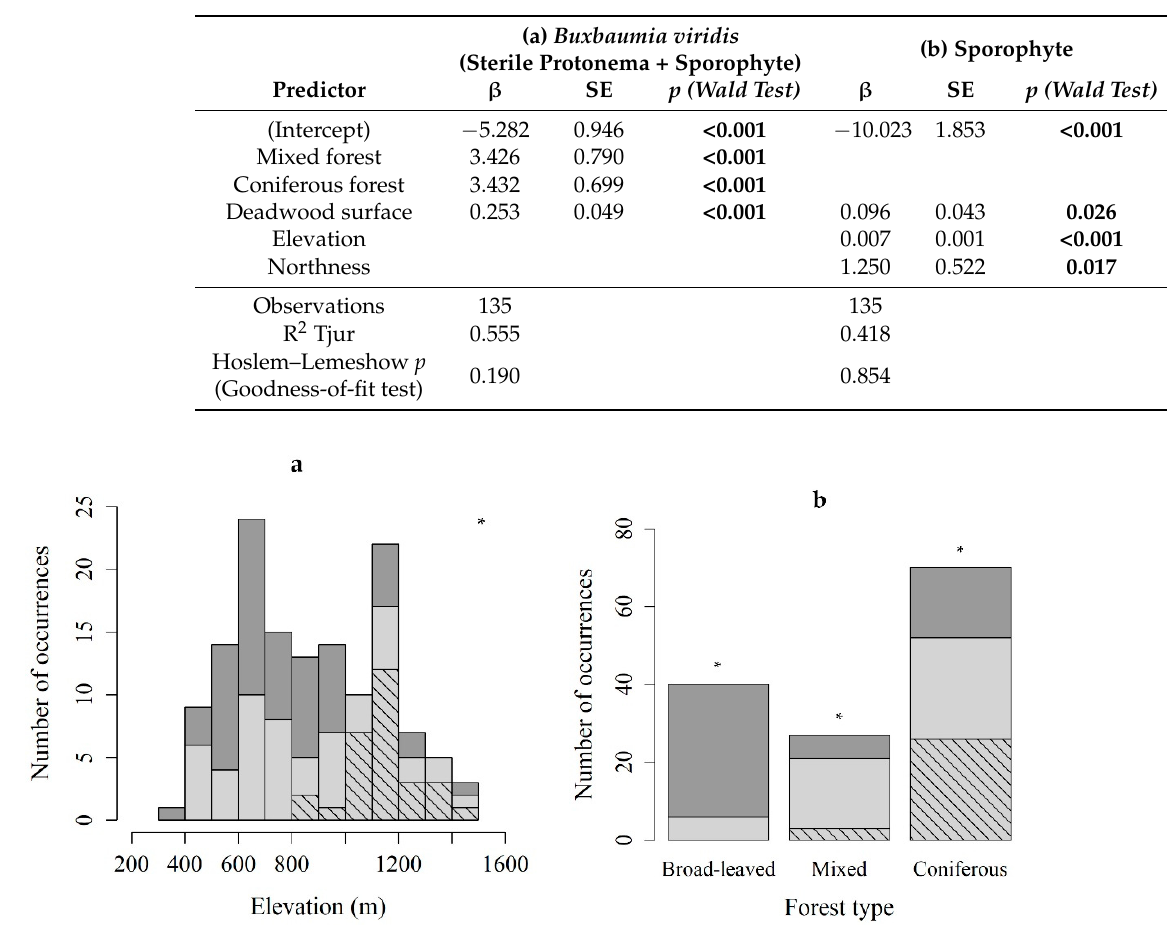
Table 2. Logistic regression results after model simplification using stepwise selection procedure